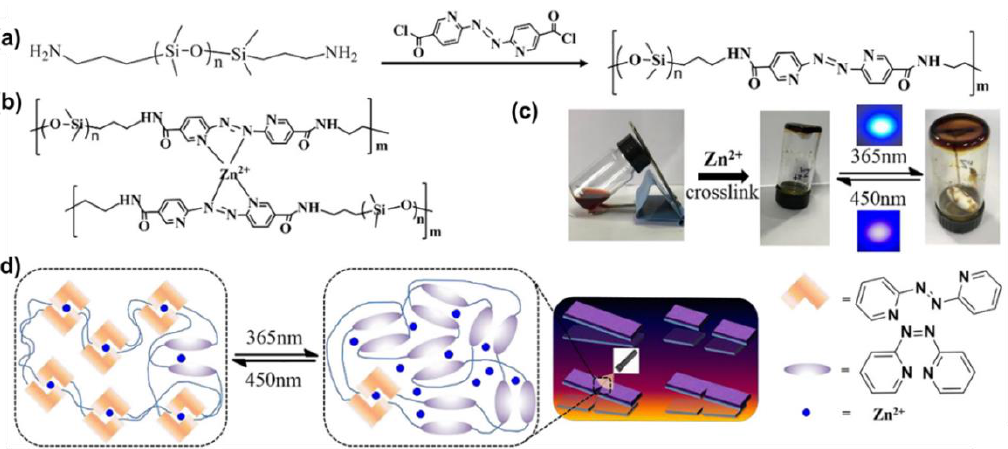
Figure 20. ( a ) Chemical structure and photoinduced dimensional transition of the PAzPCC self- assembly, insets SEM images of assemblies upon the irradiation of 365 nm light for different times. ( b ) The coordination interaction of AzPy gelator with Ni 2+ , Eu 3+ , Cu 2+ , and Bi 3+ produce helical chi- rality nanofibers. Reprinted with permission from [109]. Copyright 2018, American Chemical Society.